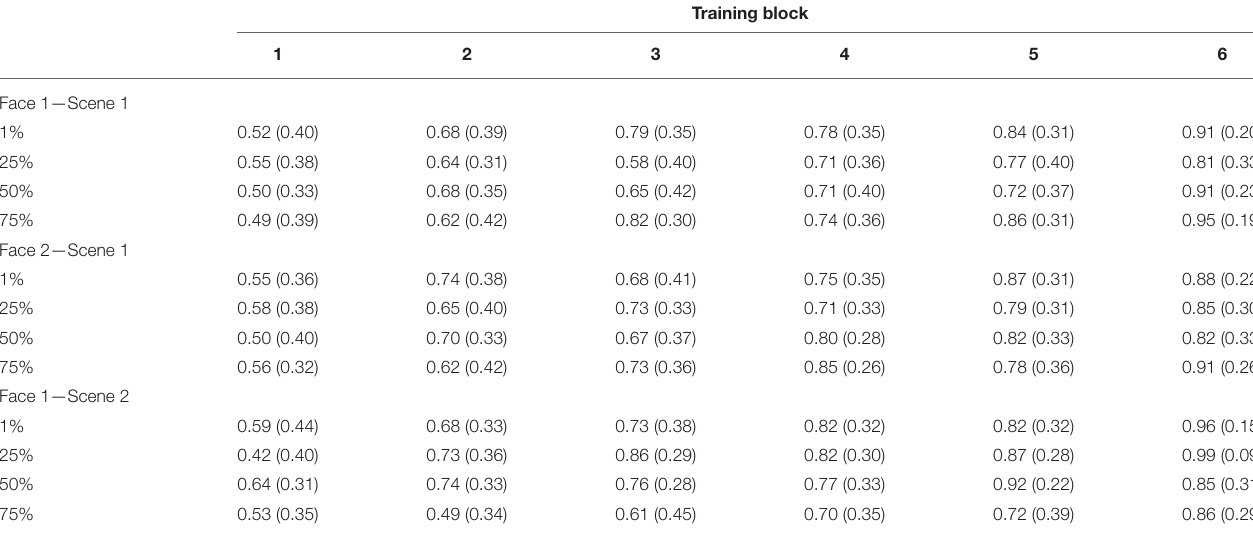
TABLE 4 | Experiment 3 training accuracy separated by block, shared parent blend level, and trained association